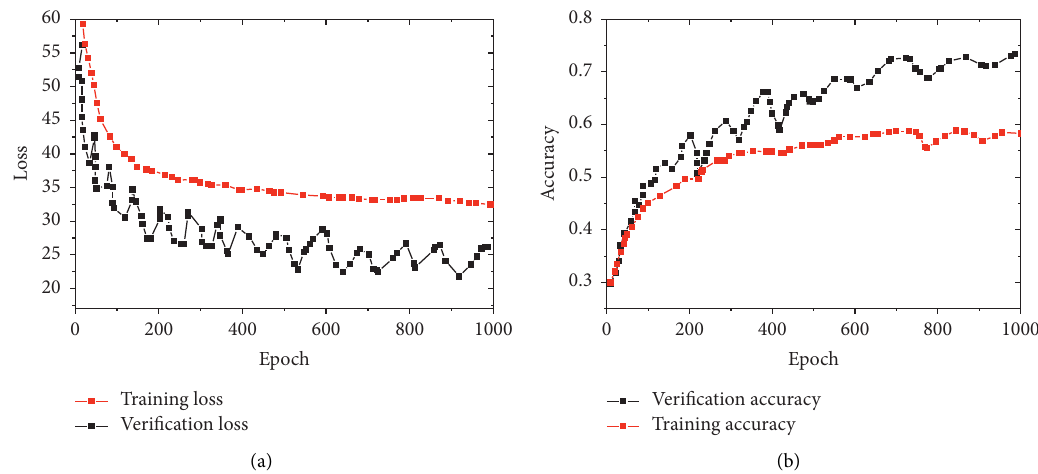
Figure 6: The loss and accuracy of the model after training on different